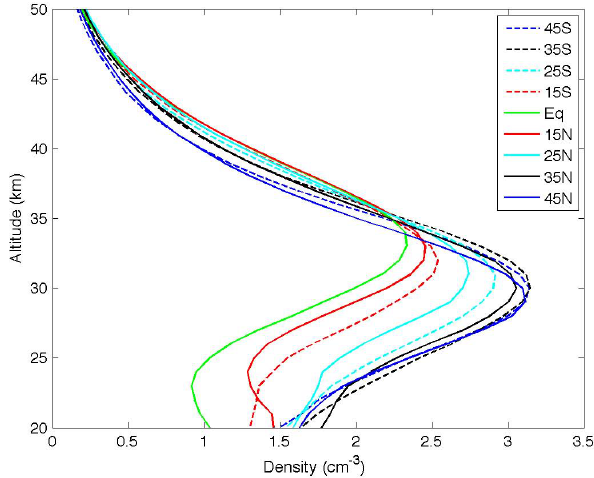
Fig. 20. The NO 2 constant factor profiles c(z) as a function of altitude for several latitude belts. The profile values are scaled by 10 9